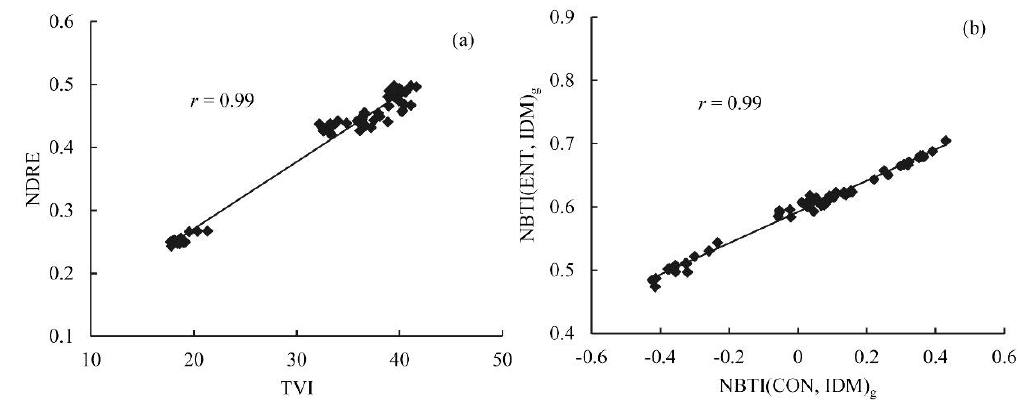
Figure 6. Relationship between ( a ) TVI and NDRE and ( b ) between NBTI (CON, IDM) g and NBTI (ENT, IDM) g .